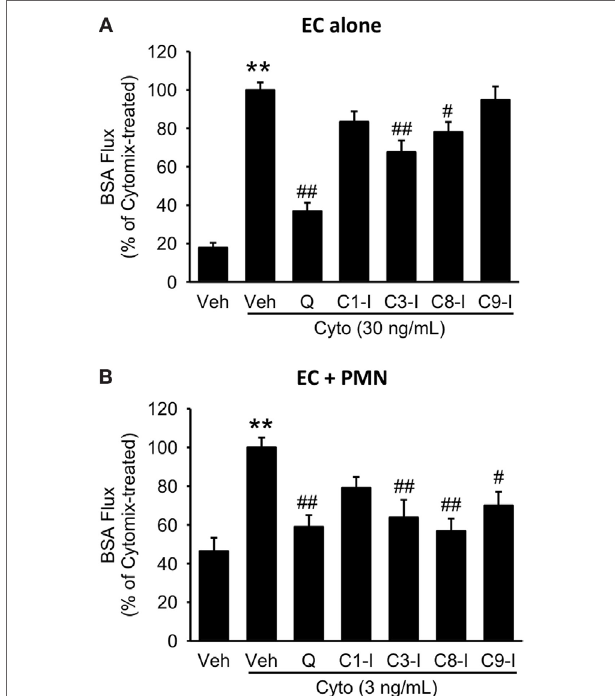
FigUre 9 | Effect of pan-caspase vs. selective caspase inhibition on septic hyper-permeability in human PMVEC alone or cocultured with PMN. (a) In isolated PMVEC, pan-caspase inhibition with Q-VD treatment markedly inhibited cytomix-induced trans-PMVEC bovine serum albumin (BSA) flux. Inhibition of caspase3 (C3-I) and caspase8 (C8-I) had a similar but smaller inhibitory effect on septic PMVEC hyper-permeability, but inhibition of caspase1 (C1-I) or caspase9 (C9-I) had no effect. (B) In PMN–PMVEC cocultures, pan-caspase inhibition with Q-VD almost completely inhibited septic PMVEC hyper-permeability, with similar effects of individual caspase3, caspase8, and caspase9 inhibition, and no effect on septic PMVEC hyper-permeability of inhibition of caspase1. ** p < 0.01 for cytomix vs. non-cytomix treatment; # p < 0.05 and ## p < 0.01 for caspase inhibitor treatments vs. cytomix alone (one-way ANOVA). n = 7–8.